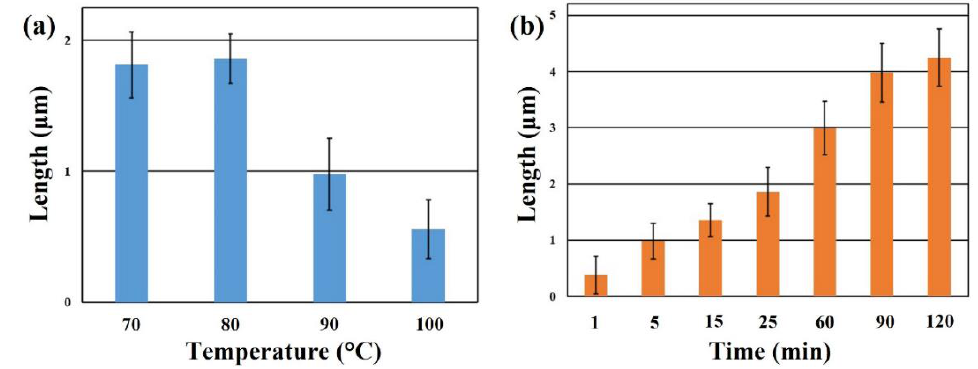
Figure 3. The average lengths of ZnO nanoneedle arrays at different ( a ) reaction temperatures and ( b ) reaction times (reaction time: 1 min (heating time) + holding time).